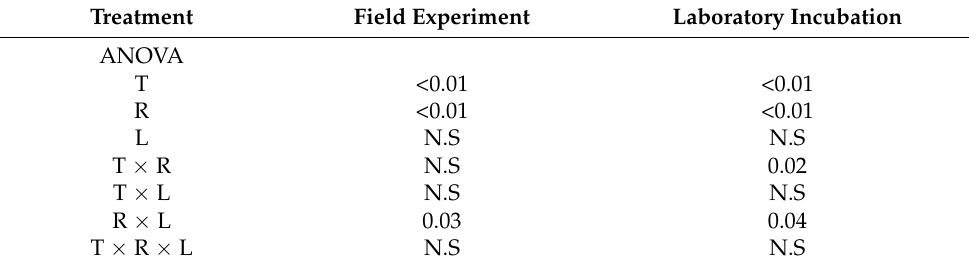
Table 3. ANOVA of SOC mineralizability under different treatments. Treatment